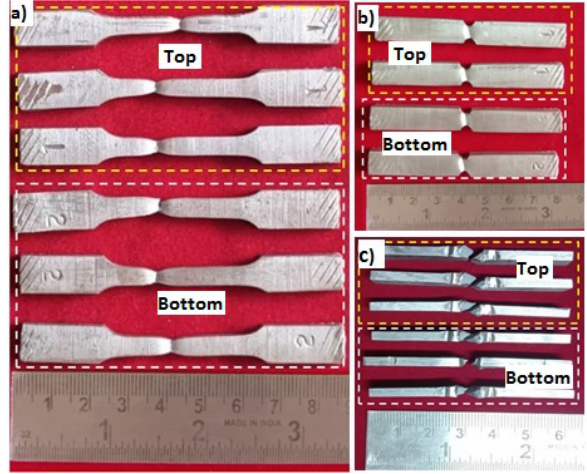
Figure 6: The photographs of the tested specimens, a) smooth ten- sile specimens, b) notch tensile specimens and c) impact toughness specimens.